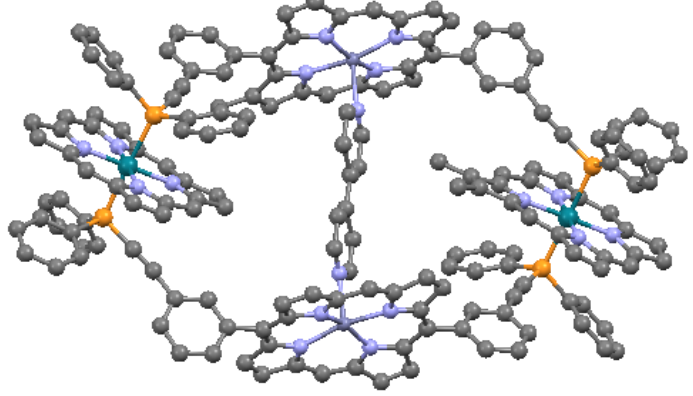
Figure 18. Mixed metalloporphyrin cage, from data in [7,54]. Dark blue = Zn, dark green = Rh, orange = P. Cl is not shown.